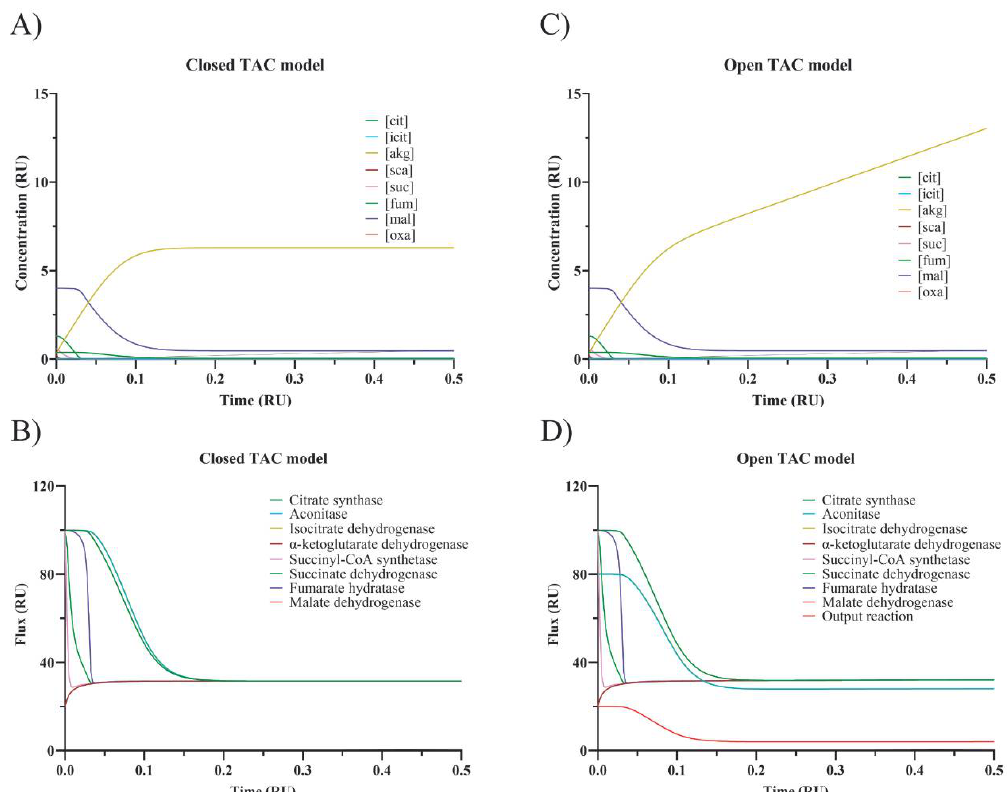
Figure 3. Dynamic variation of flux trough every step and of intermediate concentrations in the closed and open TAC when V4 (α-ketoglutarate DH) is reduced by 5-fold. The closed cycle (panels A , B ) refers to that depicted in Figure 1B and the open cycle (panels C , D ) to that depicted in Figure 1C. RU: relative Units.